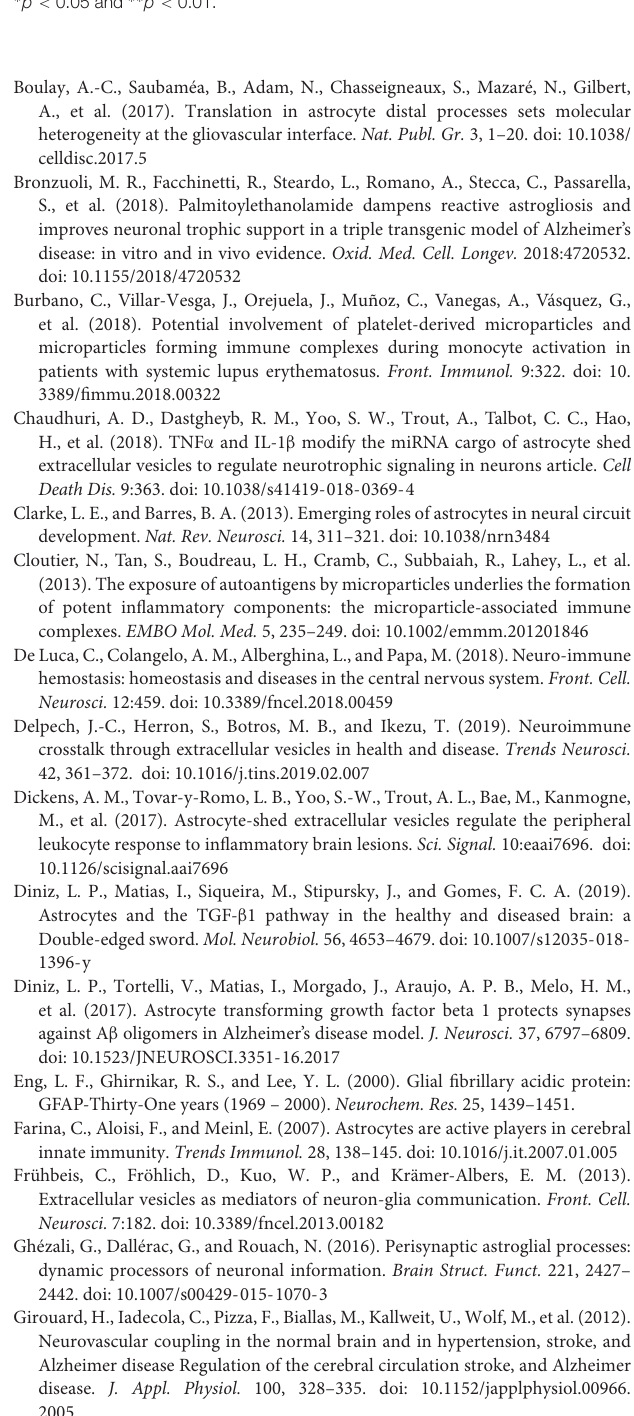
treatment with CM from PS1-KI and 3xTg-AD astrocytes. Scale bar: 50 µ m. (B) Treatment with CM from PS1-KI and 3xTgAD induced a significant increase in the number and total area of F-actin spots in endothelial cells compared with that in the untreated control cultures. Ten fields per treatment were analyzed for each n . n from 4 to 5. Comparison with ∗ , Control; #, CM-C57BL6. P-value significance: ∗∗∗ 0.001; ∗∗ 0.01; ∗ 0.05. Supplementary Figure 3 | Structural deterioration of the blood vessels is greater in SAD. (A) Representative images of segmented blood vessels projected in the Z